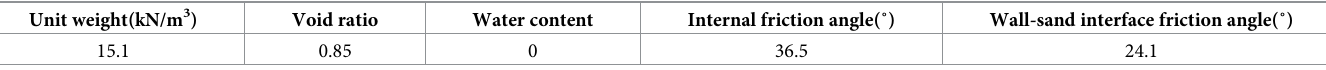
Table 1. Properties of the tested